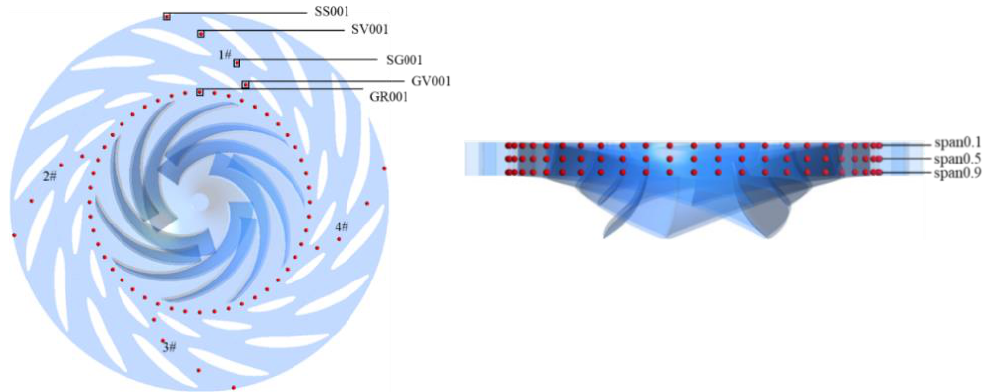
Figure 6. Monitoring points in the stay guide vanes.